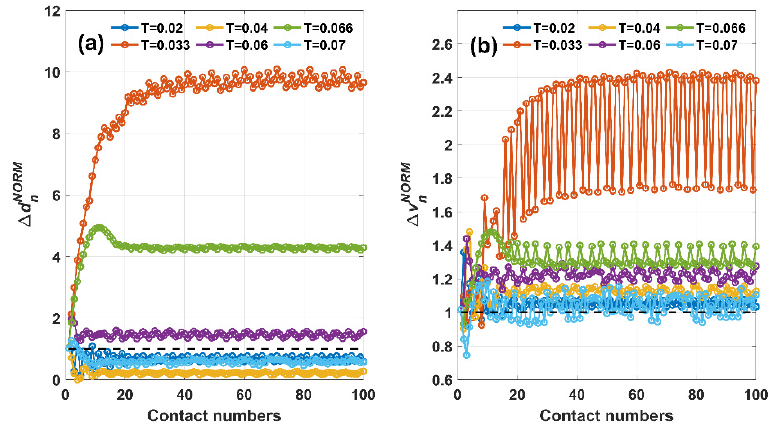
Figure 3. Normalized ratio vs. contact numbers: ( a ) displacement; ( b ) velocity.